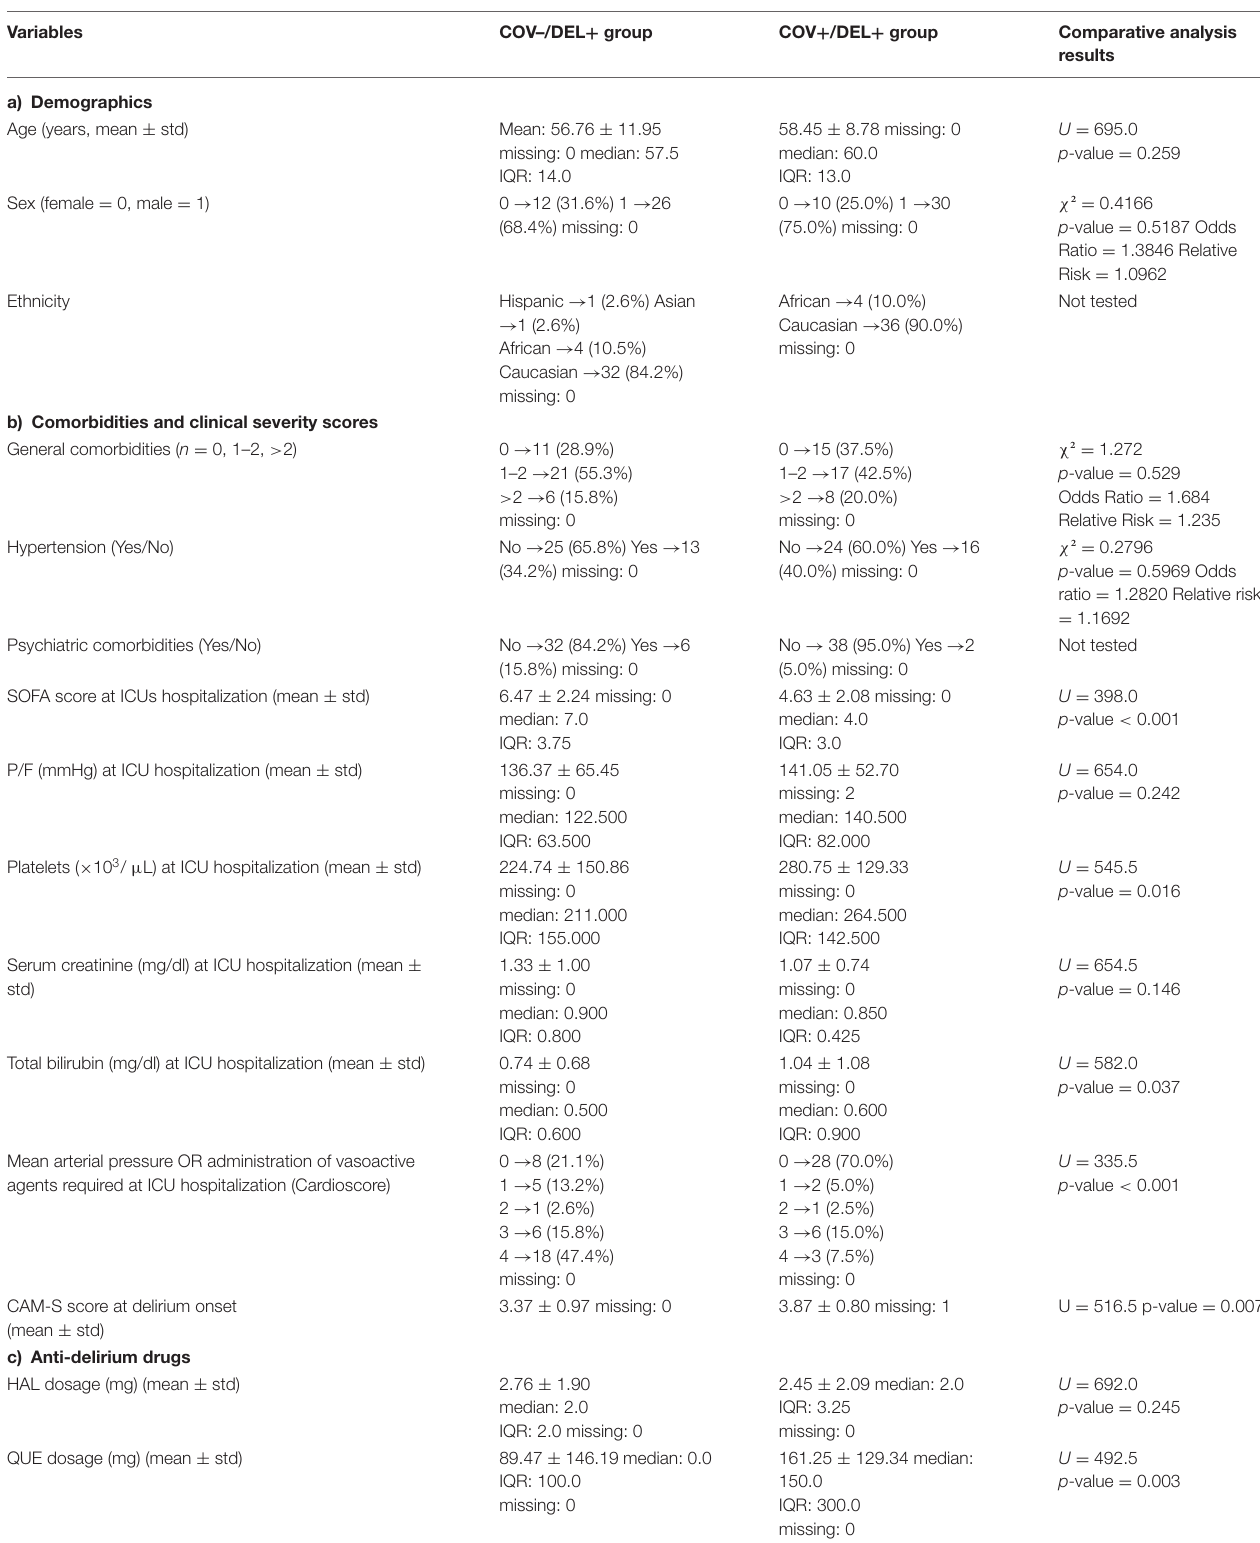
TABLE 1 | Results from descriptive and comparative analysis carried out in the two groups and including: (a) demographics; (b) presence of comorbidities (hypertension and psychiatric disorders) at ICUs hospitalization, SOFA and CAM-S scores, respectively indicating the systemic severity at ICUs admission and the delirium severity at the onset, and (c) anti-delirium drugs dosage (mg) used in the two groups of patients.